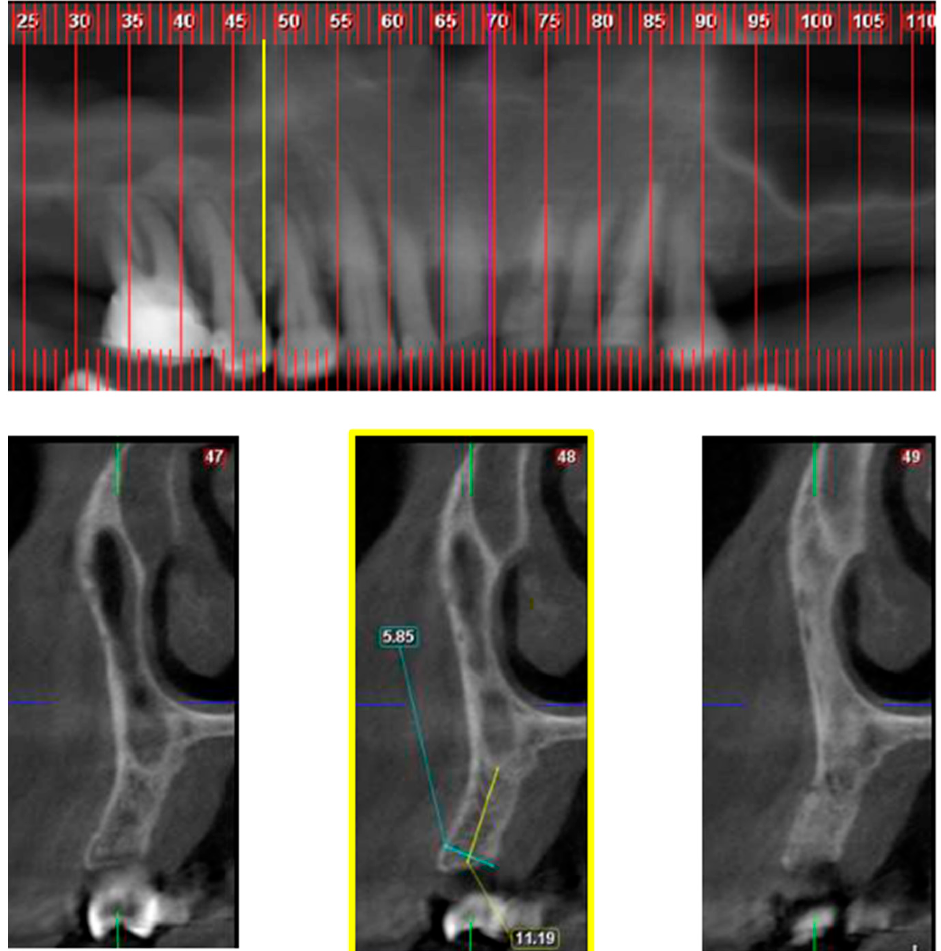
Figure 2. Class 2; Upper part—CBCT panoramic reconstruction; Lower part—from right to left— CBCT cross sections: cross section number 49—demonstrate nasal cavity alone above the alveolar ridge; cross section number 48—yellow line and frame—demonstrate nasal and maxillary sinus “border cross section”, which is located between 1st and 2nd premolars, defined as Class 2; cross section number 47—demonstrate one cross section distal to the “border cross section”.